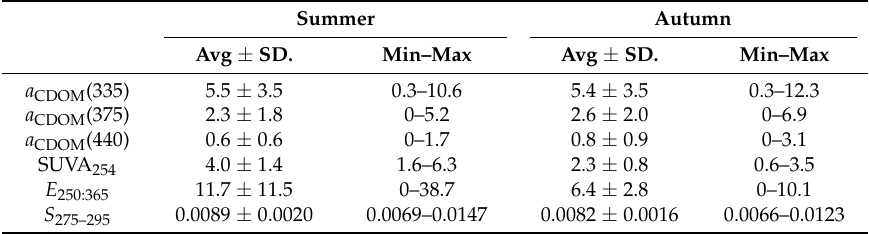
Figure 5. Absorption characteristics of sampling locations from the Yinma watershed: ( a ) absorption spectrums of CDOM ( a CDOM ) in summer; ( b ) absorption spectrums of CDOM ( a CDOM ) in autumn; and ( c ) average absorption spectrums of CDOM ( a CDOM ). The red line marks at 335, 375 and 440 nm. Table 3. CDOM absorption parameters of water sampling locations collected in the watershed.